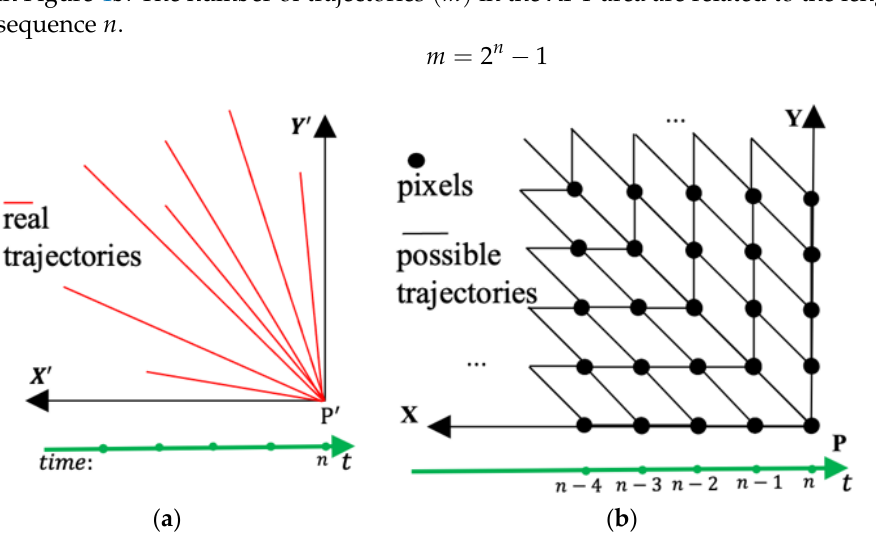
Figure 4. Possible trajectories in the target search area: ( a ) the trajectories in 2D space and ( b ) the trajectories in 2D image space. It is a tree-structured trajectory